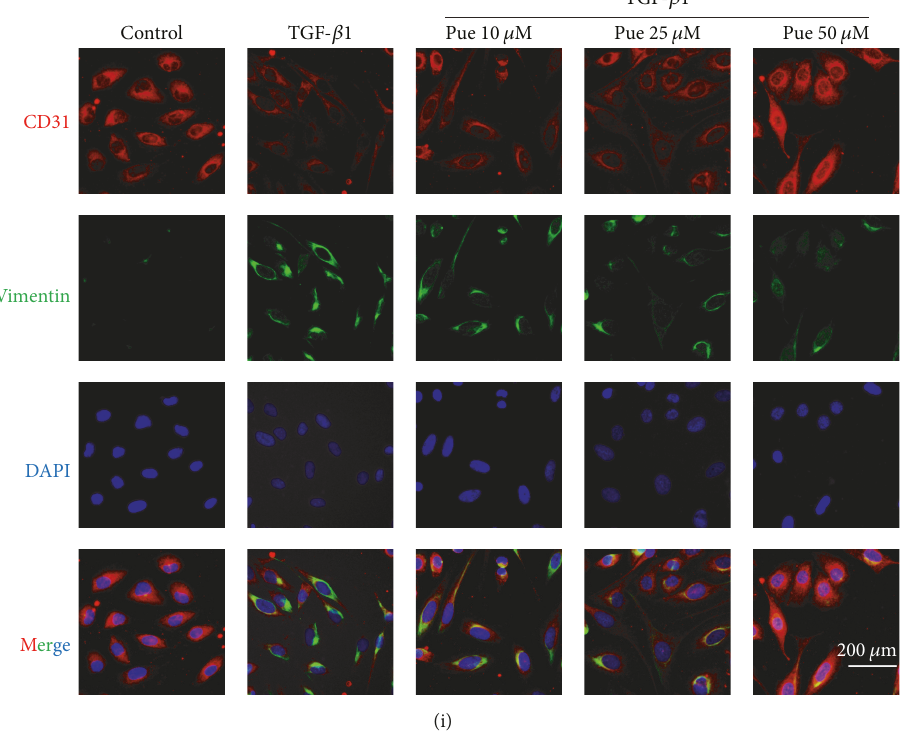
Figure 3: Puerarin inhibited TGF- 𝛽 1-induced EndMT in HUVECs . (a–g) HUVECs were preincubated with different concentrations of puerarin (10, 25, and 50 𝜇 M) for 30 min and then treated with TGF- 𝛽 1 (10ng/ml) for 48h. mRNA levels of CD31, vimentin, 𝛼 -SMA, collagen I, collagen III, CTGF, and Fn in indicated groups were tested by RT-PCR, normalized to GAPDH (𝑛 = 6) . ∗ 𝑝 < 0.05 versus control group; # 𝑝 < 0.05 versus TGF- 𝛽 1 group. (h) HUVECs were treated in the same way as mentioned above. The protein levels of CD31 and vimentin in cell lysates in indicated groups were tested by WB. ∗ 𝑝 < 0.05 versus control group; # 𝑝 < 0.05 versus TGF- 𝛽 1 group. (i) HUVECs were treated in the same way as mentioned above. Immunofluorescence colocalization of CD31 (red) and vimentin (green) counterstained with DAPI (blue) was carried out in indicated groups (scale bars: 200 𝜇